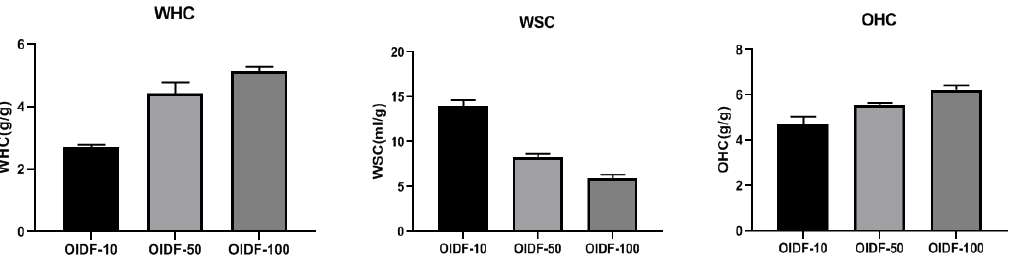
Figure 2. Effects of different particle sizes of OIDF on the water holding capacity (WHC), swelling capacity (WSC) and oil holding capacity (OHC).